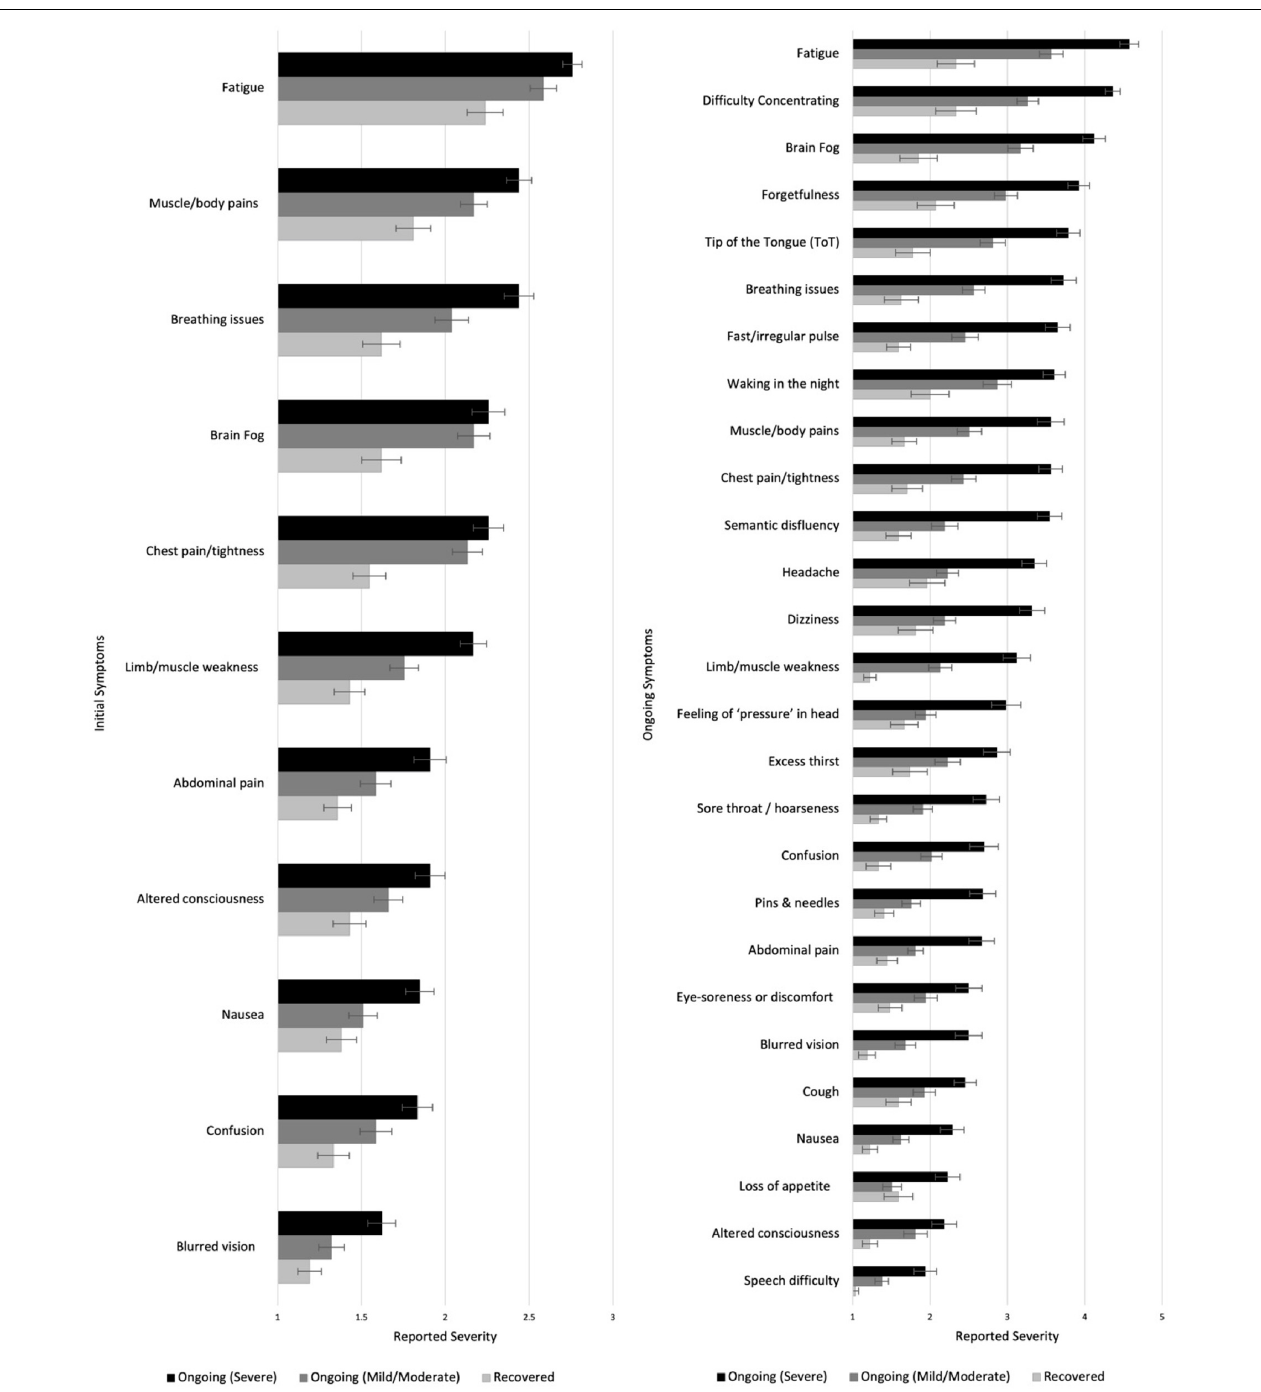
FIGURE 4 | Severity of different symptoms during the initial (left) and ongoing (right) illness among those who recovered or had ongoing mild or severe illness. Higher scores indicate higher severity.